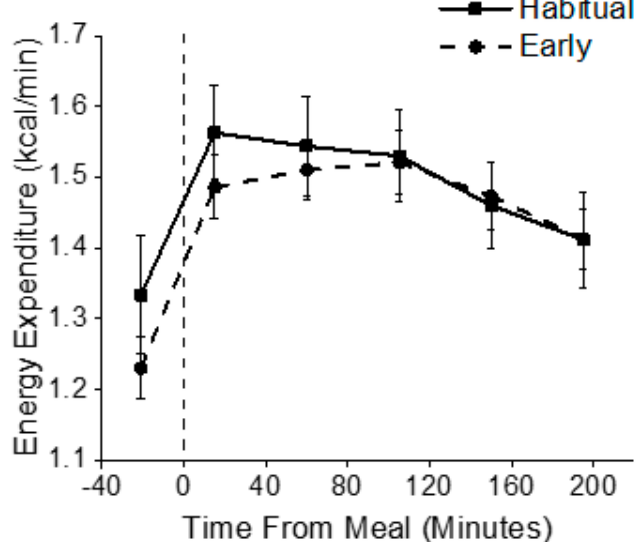
Figure 3. Glucose and Insulin Concentrations. Plasma glucose ( A ) and insulin ( B ) levels during habitual sleep (squares) and simulated early morning shift work (circles) conditions. The vertical dashed line represents the start of the scheduled meal. * Denotes p < 0.05 between time points.